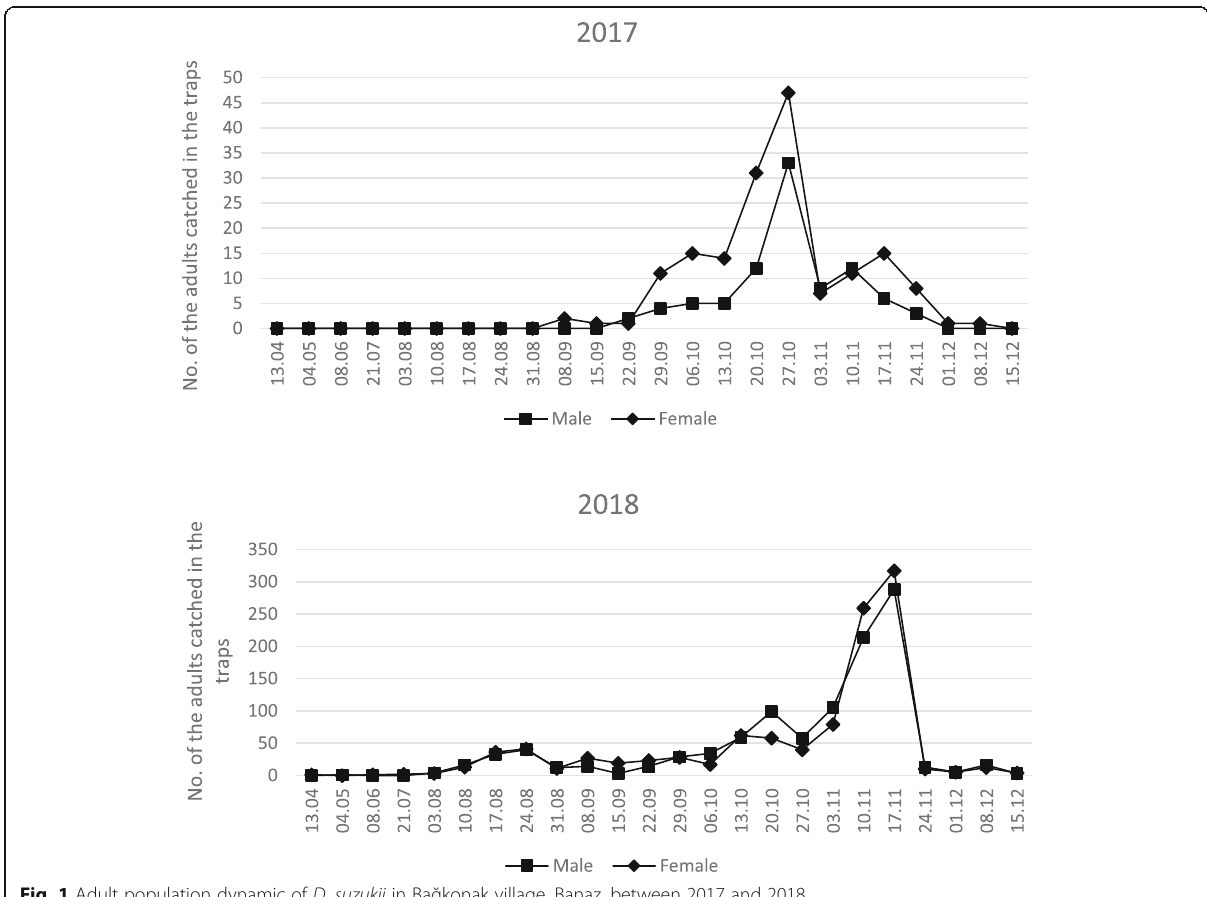
Fig. 1 Adult population dynamic of D. suzukii in Ba ğ konak village, Banaz, between 2017 and